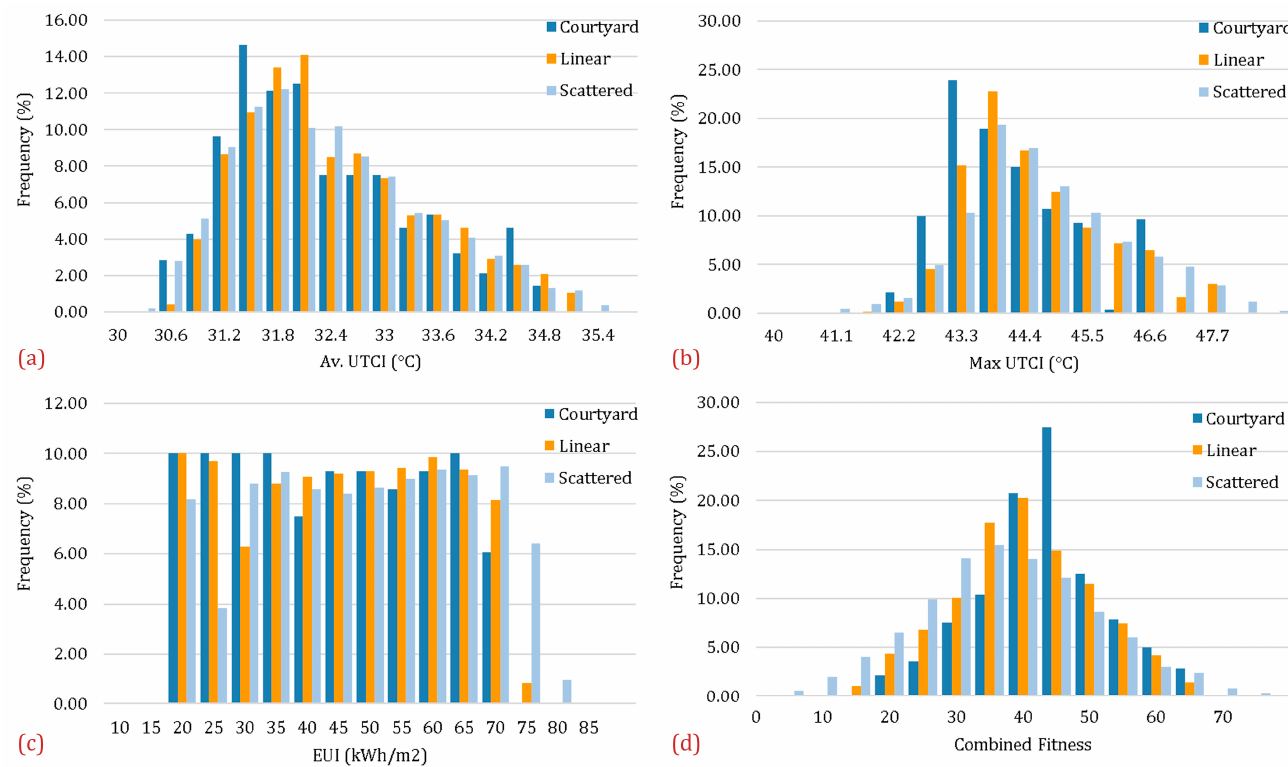
Figure 4. Frequency distribution of ( a ) Av.UTCI, ( b ) max UTCI, ( c ) EUI, and ( d ) combined fitness, over the three typologies.